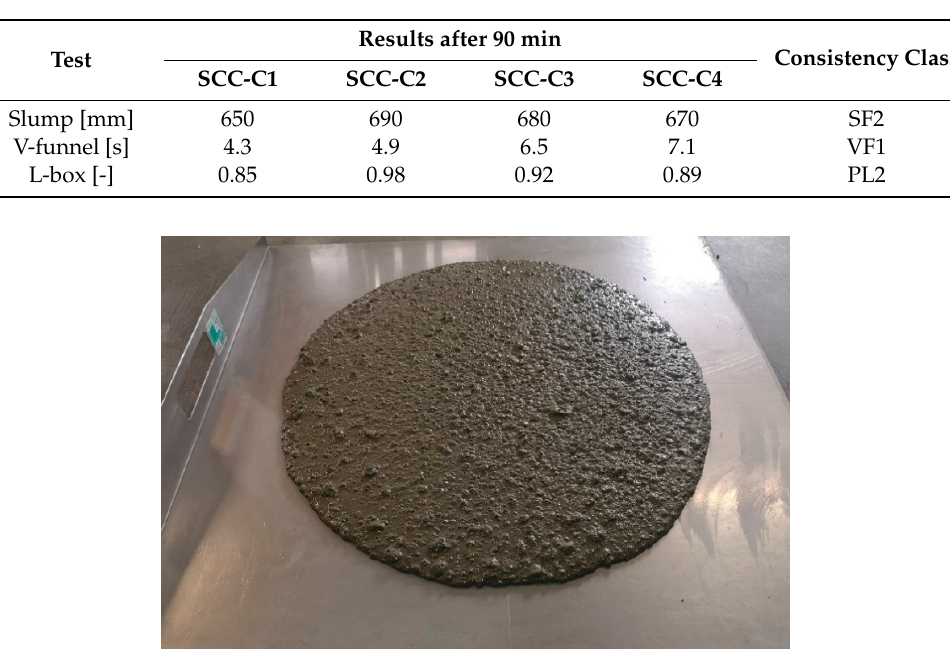
Figure 11. Concrete mixture SCC-C1.